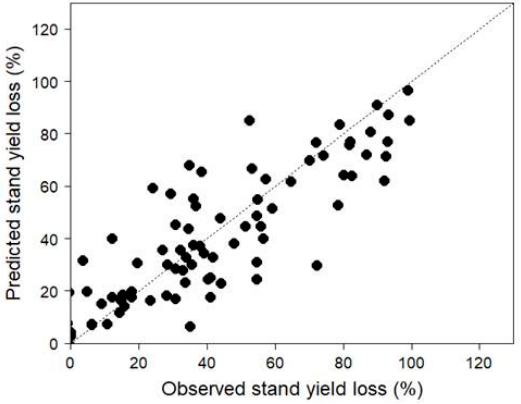
Figure 3. Model validation for four tested sites (100 plots total). Observed versus predicted values of proportion of stand yield loss. The dotted line represents to the 1 to 1 relationship.